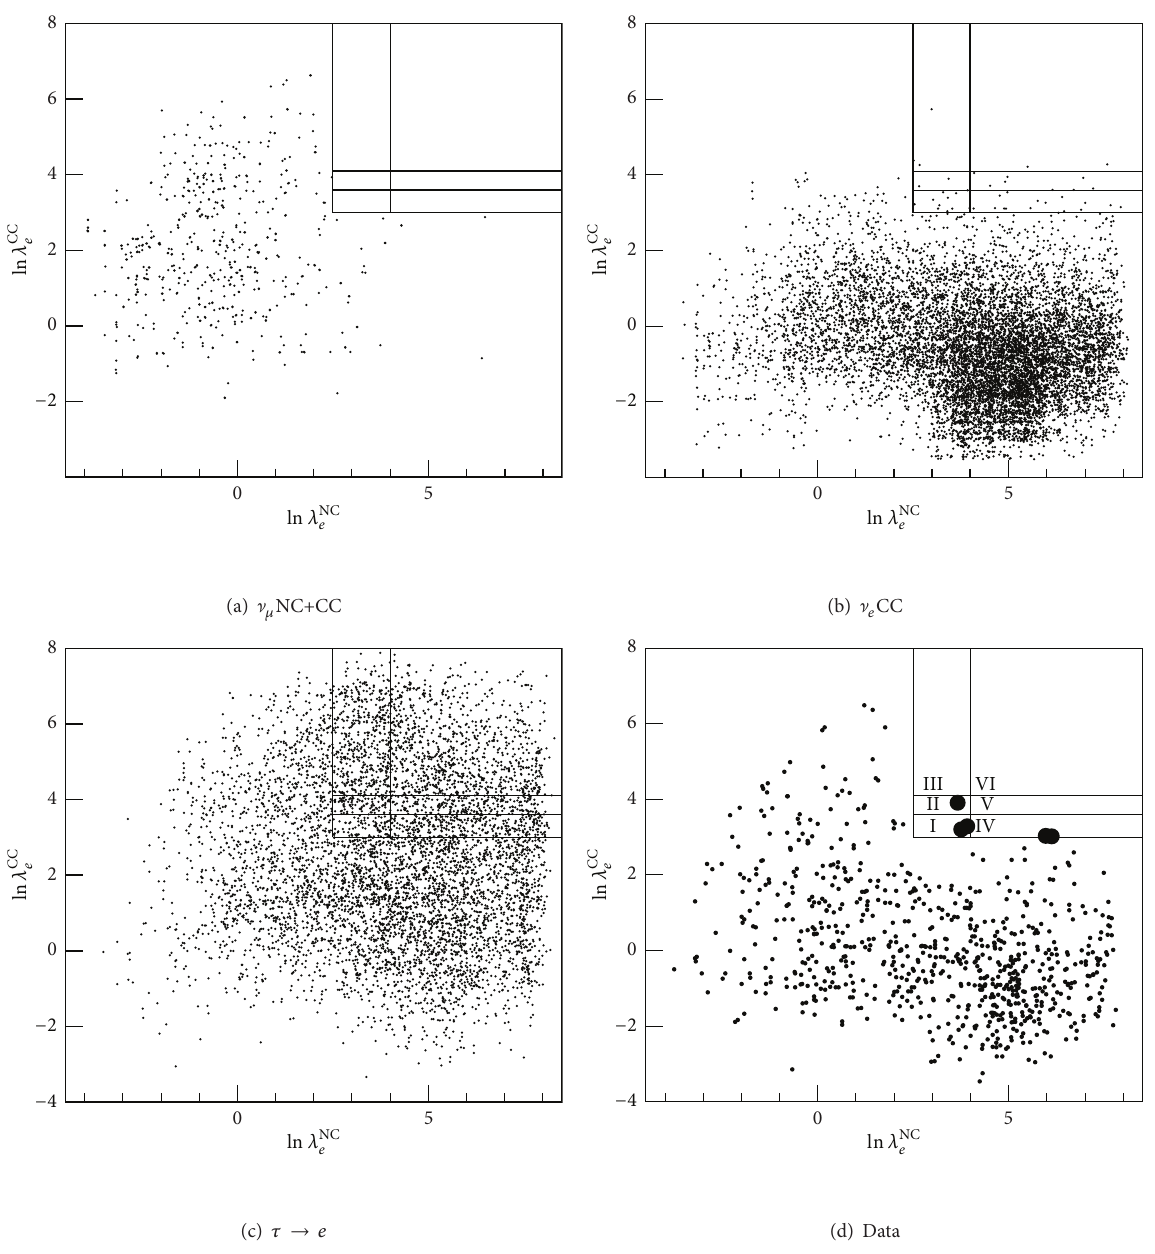
Figure 9: Scatter plot of ln 𝜆 NC 𝑒 versus ln 𝜆 CC 𝑒 for simulated signal and backgrounds (from [10–13]). (a) MC ] 𝜇 NC events and the few surviving ] 𝜏 − → 𝑒 − ] ] ] 𝜇 CC events. (b) MC 𝑒 CC events. (c) simulated 𝑒 𝜏 events. (d) data. The box at the upper right corner indicates the signal region and is divided into subboxes for the